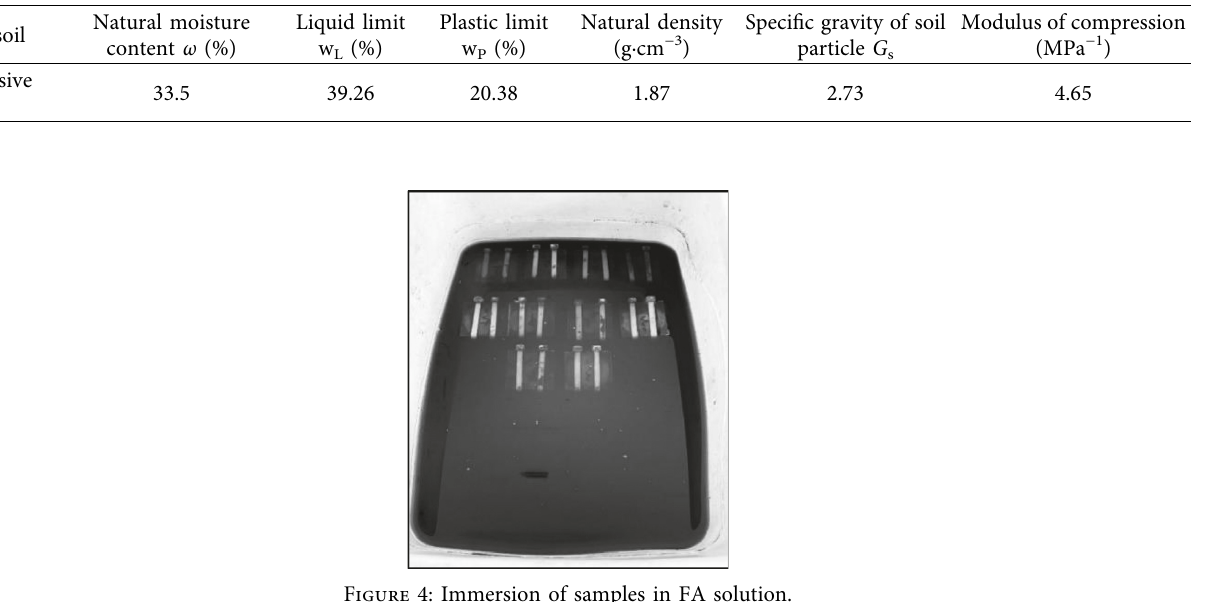
Table 2: Physical and mechanical properties index of soil for test.